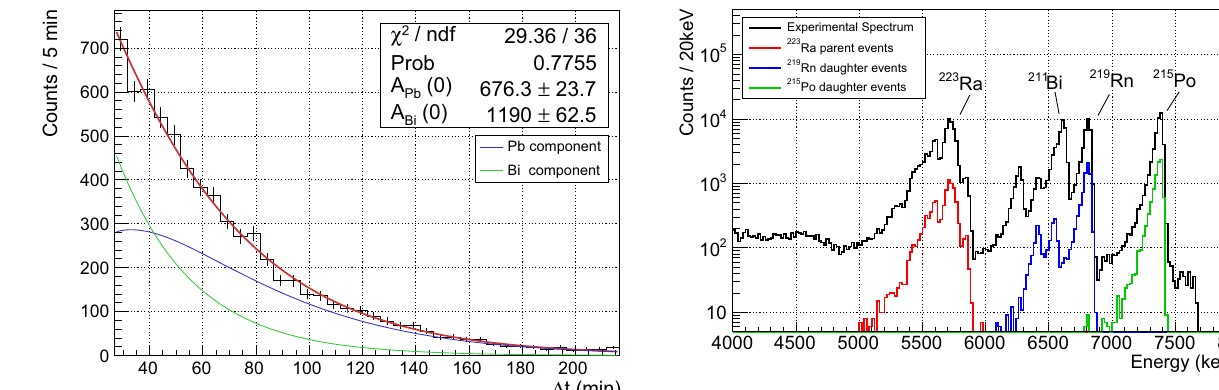
Fig. 2 Event rate of 214 Bi– 214 Po coincidences versus time. We use the Bateman equation solved for the 214 Pb → 214 Bi → 214 Po sub-chain to interpolate the experimental data. The two summed terms in the Bateman equation solution, corresponding to the decays of 214 Pb and 214 Bi nuclei initially present in the sample, are represented with blue and green functions, respectively